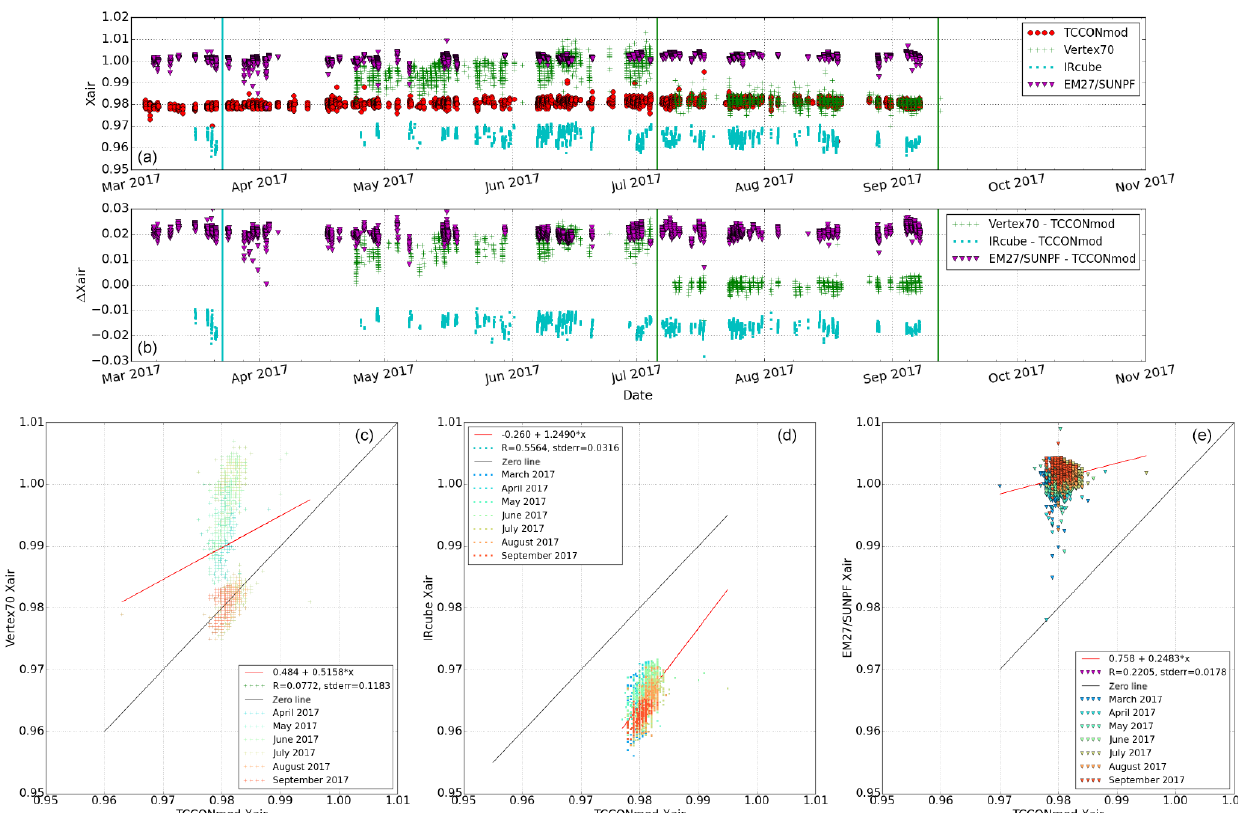
Figure 10. Time series of Xair for TCCONmod, Vertex70, IRcube, and EM27/SUN using the standard procedure with the TCCON a priori for measurements performed at Sodankylä in 2017 (a) and the difference of Xair time series for each instrument relative to the reference TCCONmod results (b) . The correlation plots of Xair from Vertex70, IRcube, and EM27/SUN instruments vs. TCCONmod for all measure- ments with SZA < 75 ◦ : (c) Vertex70 vs. TCCONmod; (d) IRCUBE vs. TCCONmod; (e) EM27/SUN vs. TCCONmod. The colours represent the measurements performed during the different months of the